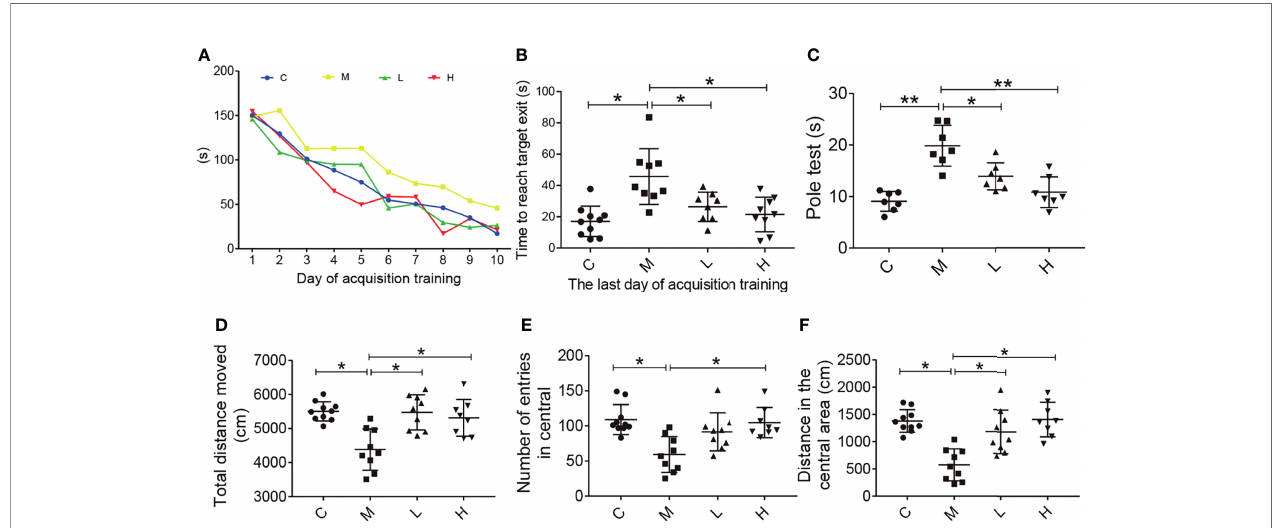
FIGURE 2 | The probiotic combination improved spatial memory, motor dysfunction, and exploratory behaviour in SAMP8 mice. (A) The time to reach the target exit during the training test (the Barnes maze). (B) The probiotic combination reduced time it took SAMP8 mice to reach the target exit during the probe test of the Barnes maze. (C) The probiotic combination improved the motor dysfunction in SAMP8 mice (the pole test). (D) The probiotic combination increased the total distance in SAMP8 mice moved in the open- fi eld test. (E) The probiotic combination increased the number of entries SAMP8 mice made in central area of the open- fi eld test. (F) The probiotic combination increased the distance SAMP8 mice moved in the central area of the open- fi eld test. C: control group (n = 10), M: model group (n = 9), L: low-dose probiotic group (n = 8), H: high-dose probiotic group (n = 9). Data are presented as the means ± SD. *p < 0.05 **p <